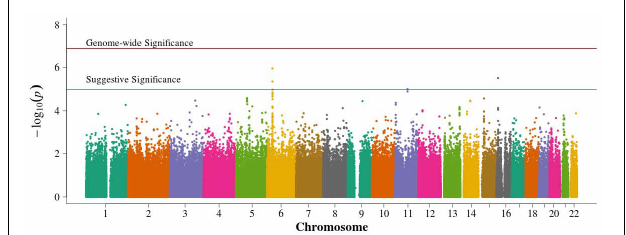
FIGURE 7 | Manhattan plot for GAP. Summary of genome-wide association scan results in the GoKinD collection of combined population-based and family-based data. The − log 10 P -values were calculated for SNP association with diabetic nephropathy using the method of Zhang et al. (2009). The red horizontal line corresponds to genome-wide significance ( P -value = 0 . 05 / 386 , 822 = 1 . 3 × 10 − 7 ). The blue horizontal line corresponds to suggestive significance ( P -value = 1 × 10 − 5